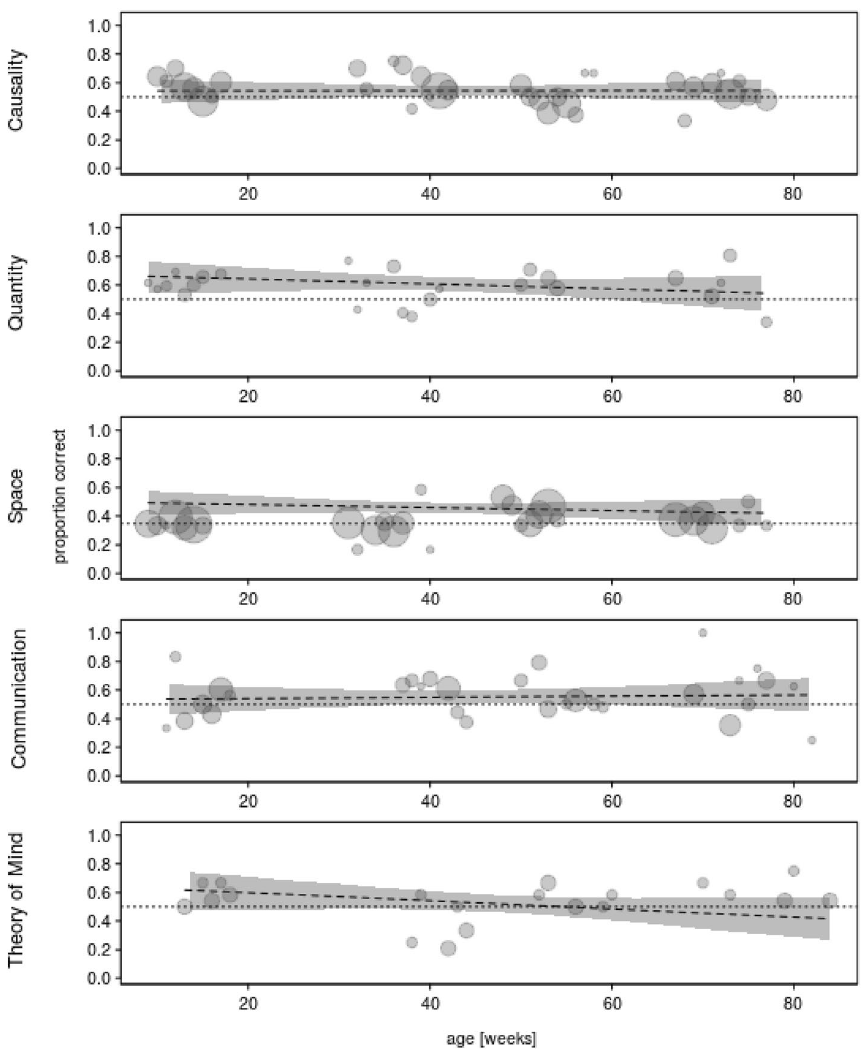
tests). The dashed line and grey area represent the fitted model and its confidence interval based on all covariates and factors, except age centered to a mean of zero. The doted horizontal lines depict chance